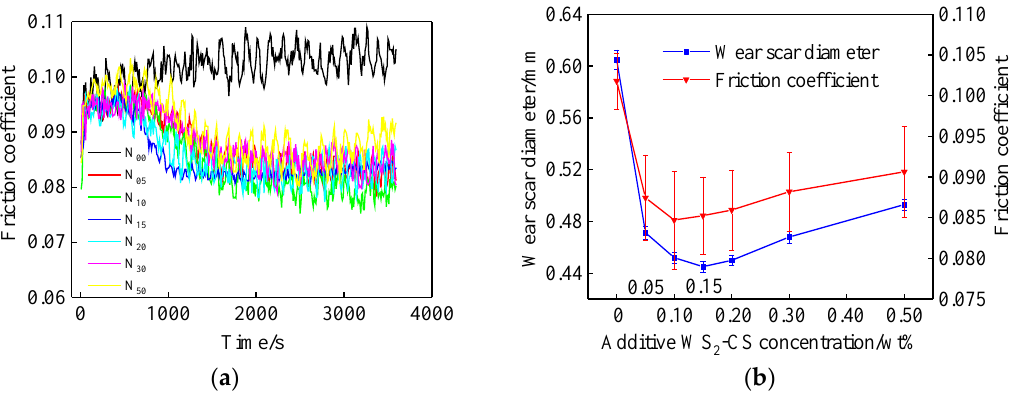
Figure 9. Curves of different additive concentrations: ( a ) varying friction coefficient; ( b ) average diameter of wear scar.